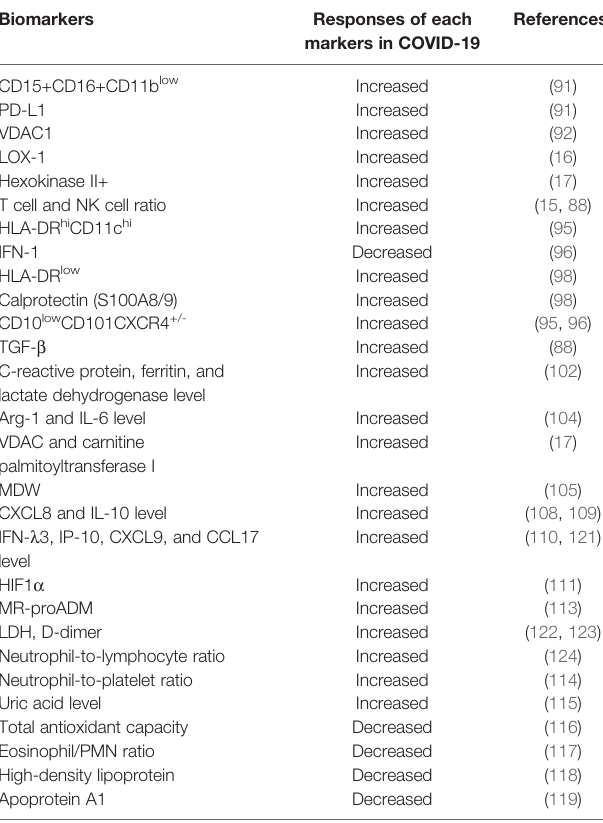
TABLE 2 | Candidates for biomarkers to identify COVID-19 severity.